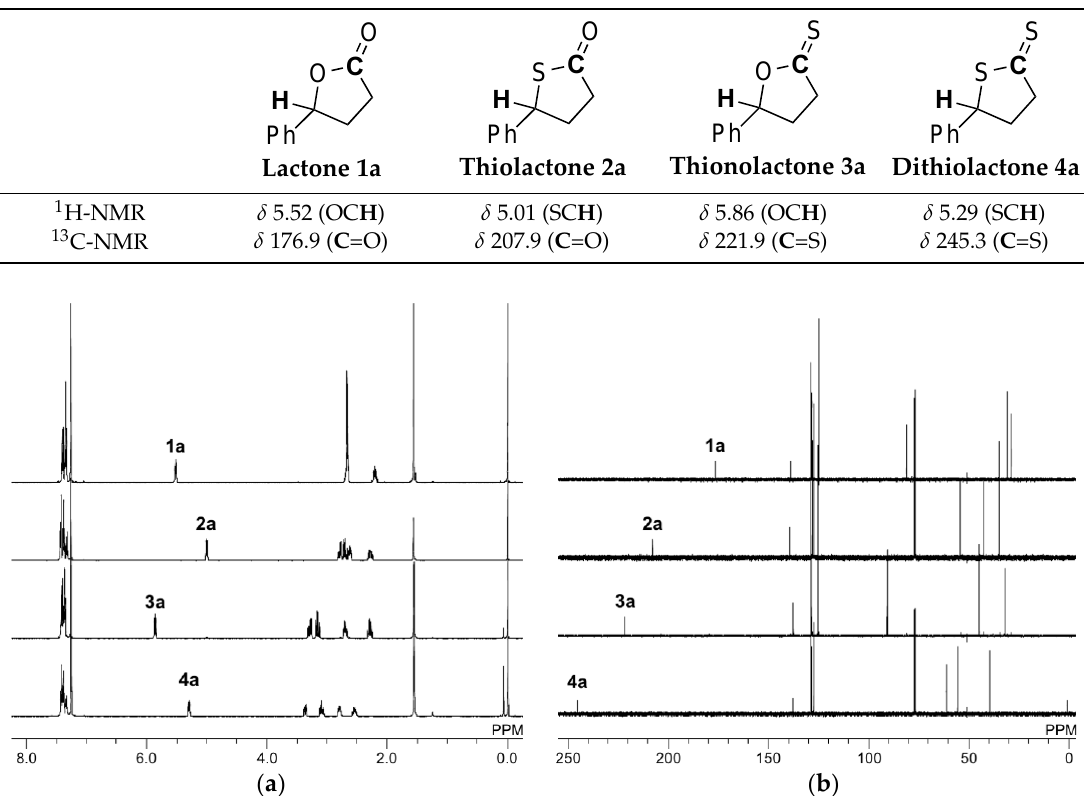
Table 2. Selected 1 H and 13 C-NMR spectral data (CDCl 3 , rt) for 1a , 2a , 3a , and 4a .